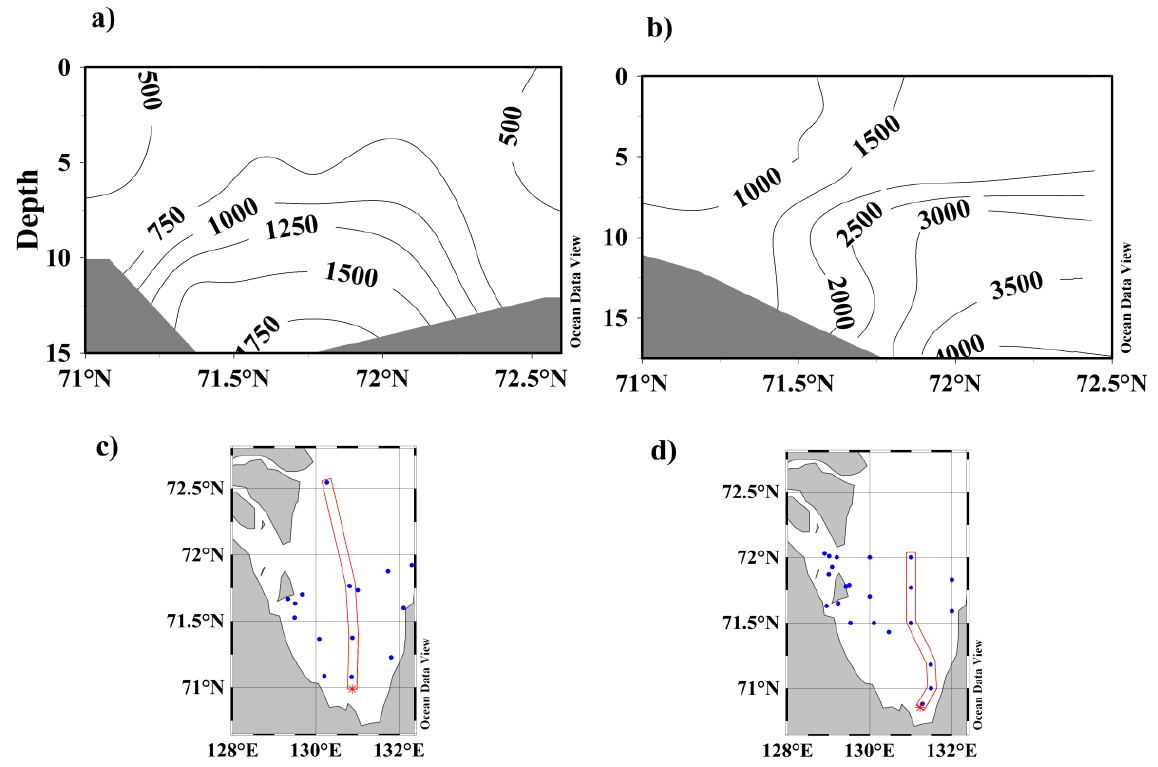
Fig. 8. Meridian vertical p CO 2 (µatm) profile across the Bur-Khaya Gulf of the Laptev Sea: (a) summertime distribution (September 1997); (b) wintertime distribution (April 2002); transect positions in (c) 1997, (d) 2002.